Question: In one sentence, what is this figure communicating?
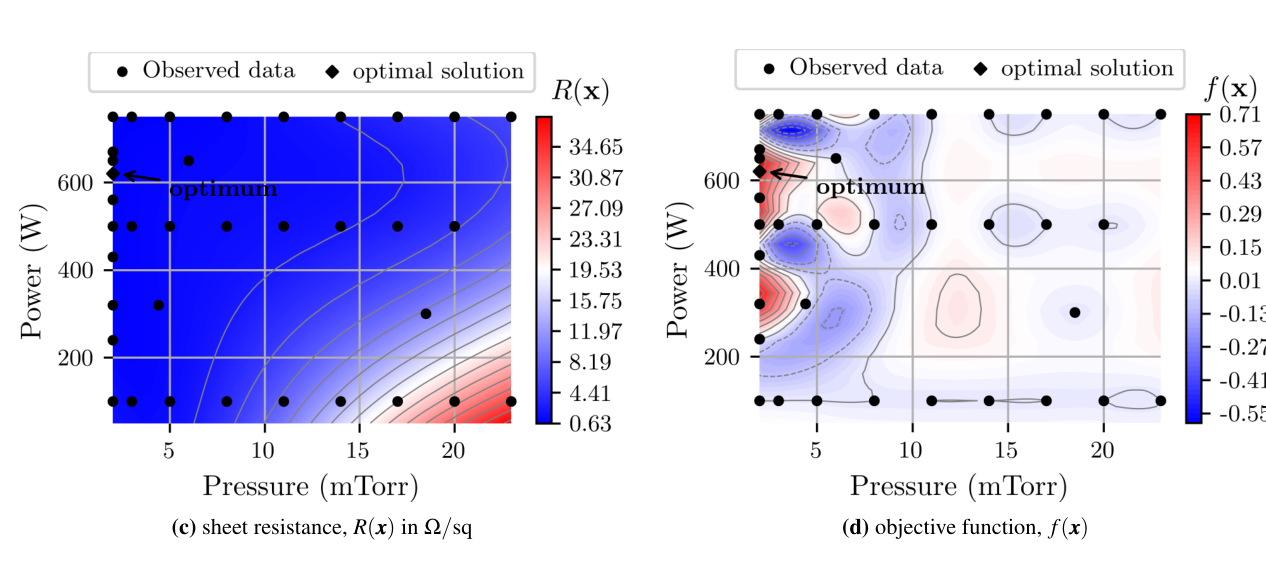
Answer: The figure shows the contour plots of stress in Fig. 8a, the derivative of stress with pressure in Fig. 8b, the sheet resistance in Fig. 8c, and the objective function f in Fig. 8d after 10 iterations. The optimal conditions are achieved at (2 mTorr,620 W), ensuring that the observed stress falls within the range of [−300,300] MPa, the sheet resistance is below 3 Ω/sq, and the derivative is both positive and at its minimum, fulfilling all specified criteria.